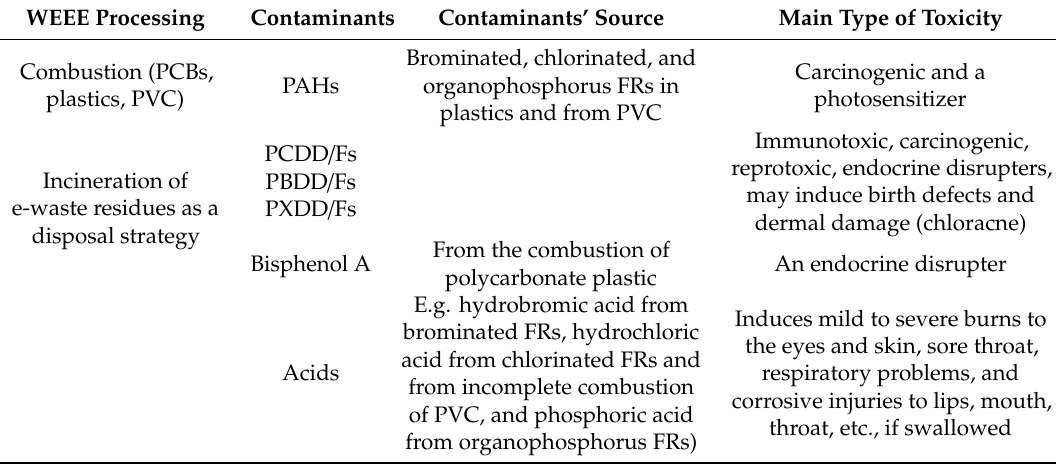
Table 2. Toxicity related to e-plastics containing flame-retardant processing